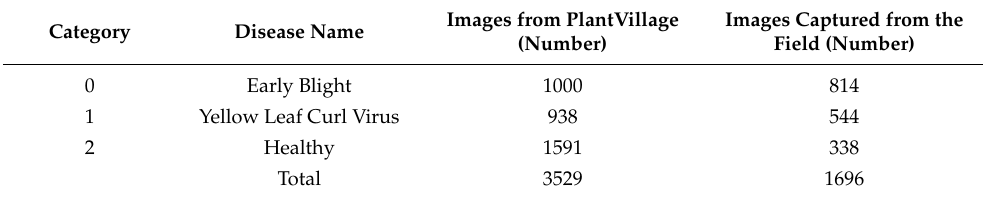
Table 1. Number of images used in the study for each